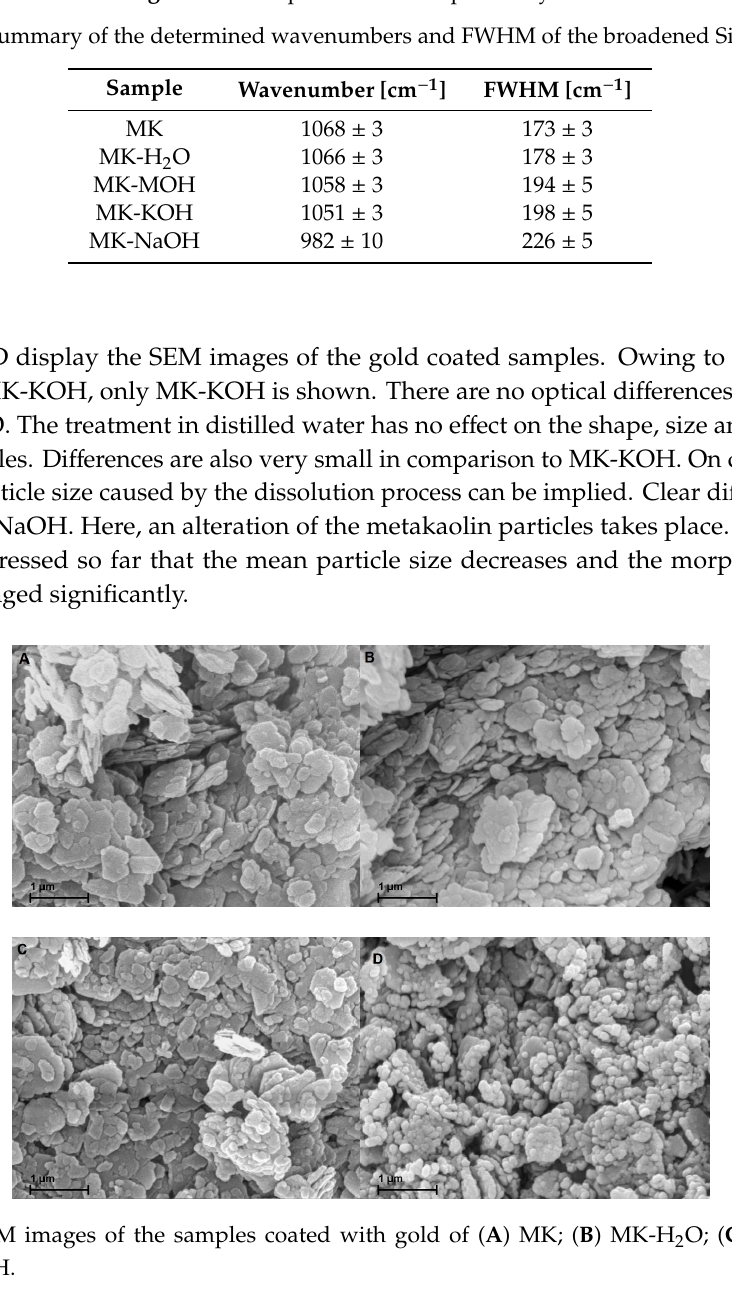
Figure 4. FTIR spectra of all samples analyzed.